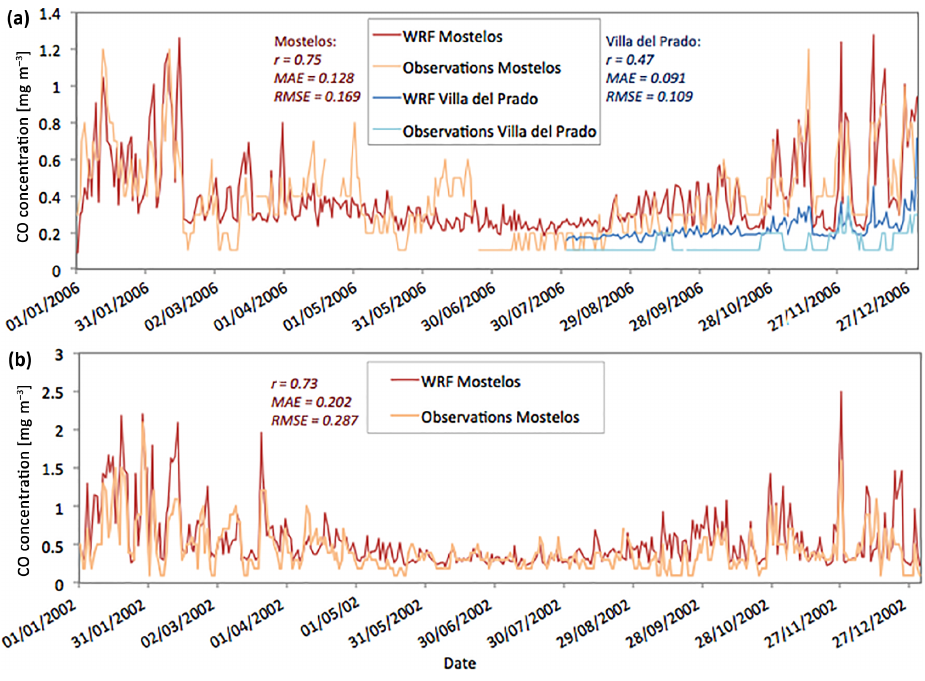
Figure 2. For 2006, above and 2002, below: daily averaged WRF surface concentrations (red and blue lines) compared to observations (orange and light blue lines) at two locations near Madrid.